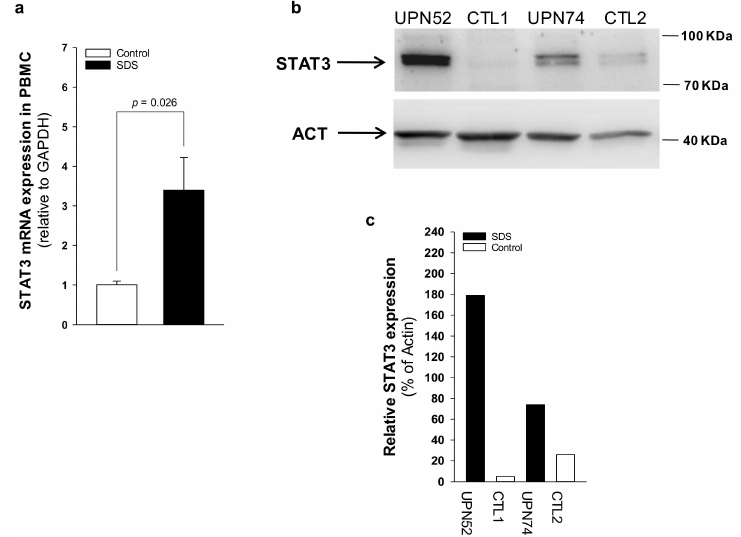
Figure 4. STAT3 transcript and protein expression is upregulated in SDS patient-derived primary PBMC. ( a ) STAT3 mRNA expression in primary PBMC isolated from UPN26, UPN69, UPN73, UPN87, UPN94, UPN106, and UPN108 (black bar), and from age-matched controls (white bar), measured by qRT-PCR. Data are mean ± SEM of seven experiments. ( b ) STAT3 protein level was measured in PBMC (UPN52 and UPN74) by Western blot analysis. ( c ) Densitometric analysis of Western blots showed in panel b . Statistics: Normal distribution was tested by the Shapiro–Wilk test. Subsequently, the Mann-Whitney Rank Sum Test was calculated and reported within